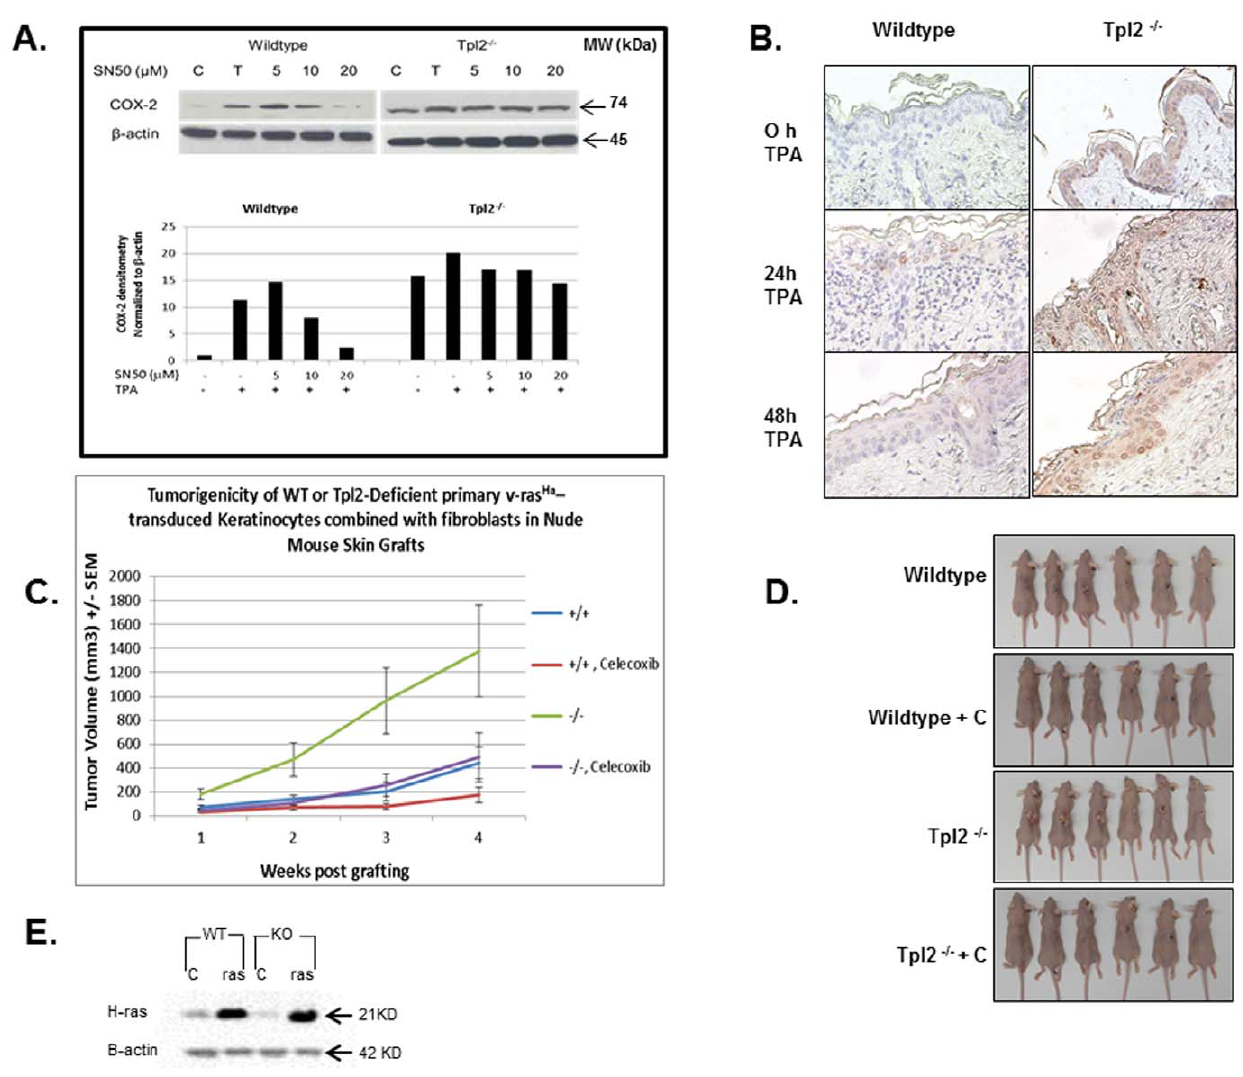
Figure 1. COX-2 signaling is augmented in keratinocytes and skin from Tpl2 2 / 2 mice. (A) Primary keratinocytes were treated with DMSO control (Lane C), TPA (Lane T) (10 ng/ml), or TPA + 5 m M, 10 m M, or 20 m M of the NF- k B inhibitor, SN50, and COX-2 expression measured 18 h later by western blot analysis. Densitometry of COX-2 after normalizion to b -actin is shown. (B) Immunohistochemical analysis of COX-2 in wildtype (WT) and Tpl2 2 / 2 mouse skin. Normal WT and Tpl2 2 / 2 skin as well as TPA-treated skin (24 or 48 hours) from WT and Tpl2 2 / 2 mice was stained for COX-2 (1:200 dilution). Magnification =10X. (C) Tumorigenicity of keratinocytes expressing oncogenic v-ras Ha in nude mouse grafts. Data are expressed as means + / 2 SEM of approximate tumor volume in mm 3 . Statistical differences were found between mice grafted with v-ras Ha transformed WT ( + / + ) or those grafted with v-ras Ha transformed KO ( 2 / 2 ) keratinocytes as well as between mice grafted with Tpl2 2 / 2 keratinocytes and those grafted with Tpl2 2 / 2 keratinocytes and fed 500 ppm Celecoxib in their diets (p , 0.01). No statistical difference was found when comparing mice grafted with Tpl2 2 / 2 keratinocytes and fed Celecoxib and mice grafted with WT cells. (D) Clinical appearance of mice grafted with v-ras Ha transformed WT or v-ras Ha transformed Tpl2 2 / 2 keratinocytes fed AIN-93G diet + / 2 500 ppm Celecoxib. (E) Western blotting of basal H-ras levels of WT or KO keratinocytes and H-ras levels post ras Ha retrovirus transduction.